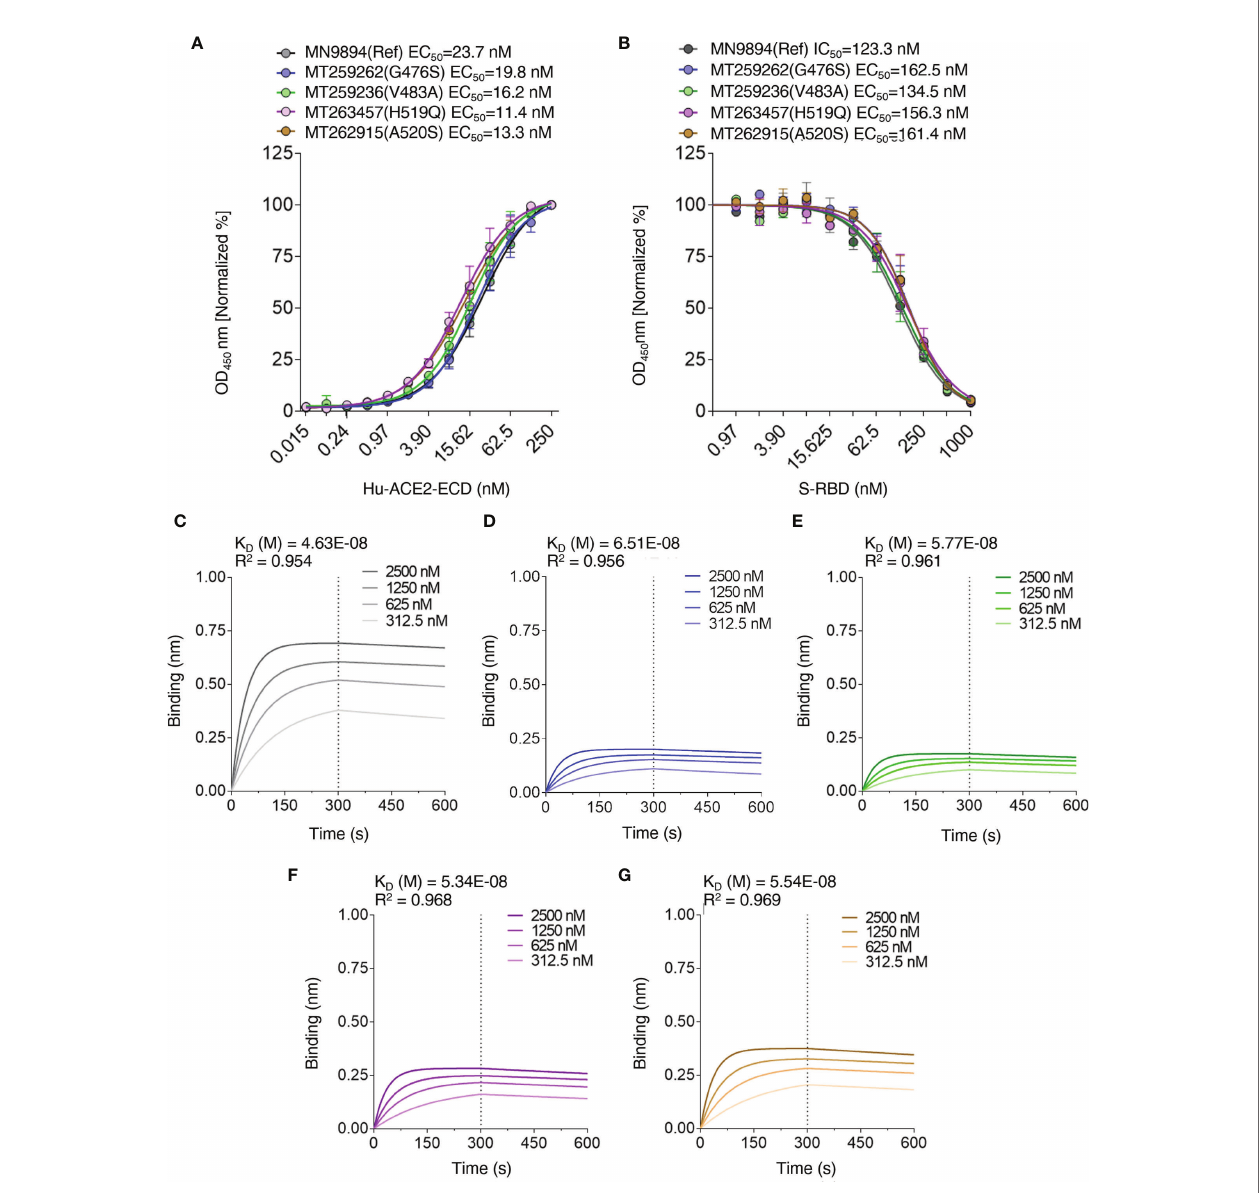
FIGURE 6 | Interaction pro fi les of S-RBD reference/mutants and hACE2-ECD. (A) EC 50 values of S-RBD – hACE2-ECD interaction were determined by direct binding ELISA using titration curves with hACE2-ECD dilutions, and (B) IC 50 values of S-RBD – hACE2-ECD interaction were determined by competitive ELISA using titration curves with S-RBD dilutions and hACE2-ECD at a predetermined EC 50 . Biolayer interferometry was used to generate association and dissociation curves of S-RBD – hACE2-ECD interaction for S-RBD reference (C) , G476S (D) , V483A (E) , H519Q (F) , and A520S (G) ; legends represent the nanomolar (nM) concentration of hACE2-ECD and K D values are depicted.